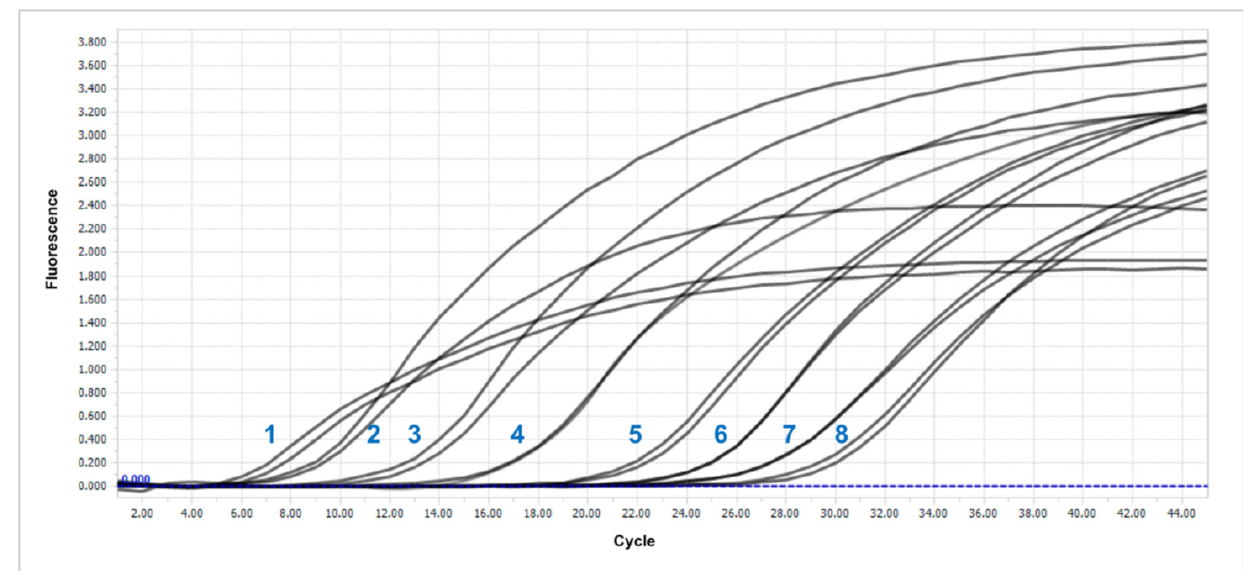
Figure 10. Amplification curves of tenfold dilutions of the test plasmid. The numbers represent the corresponding dilution shown in Table